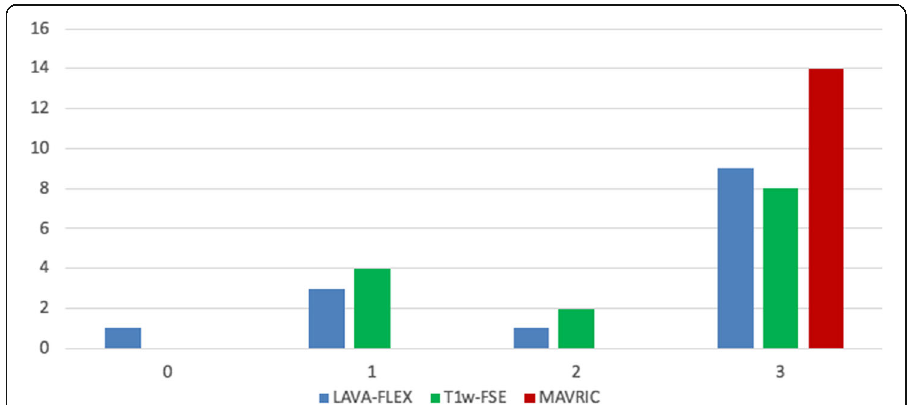
Fig. 4 Qualitative assessment of all pathological PSMA uptakes in the pelvis ( n = 14). 0 = not assessable, 1 = only partially visible, 2 = visible with substantial blurring, 3 = good depiction of anatomical structures. The reported pathological PSMA uptakes in the pelvis could all be assigned to anatomical structures without artifacts in the MAVRIC-SL sequences, e.g., prostate ( n = 7), lymph node ( n = 4), or bone